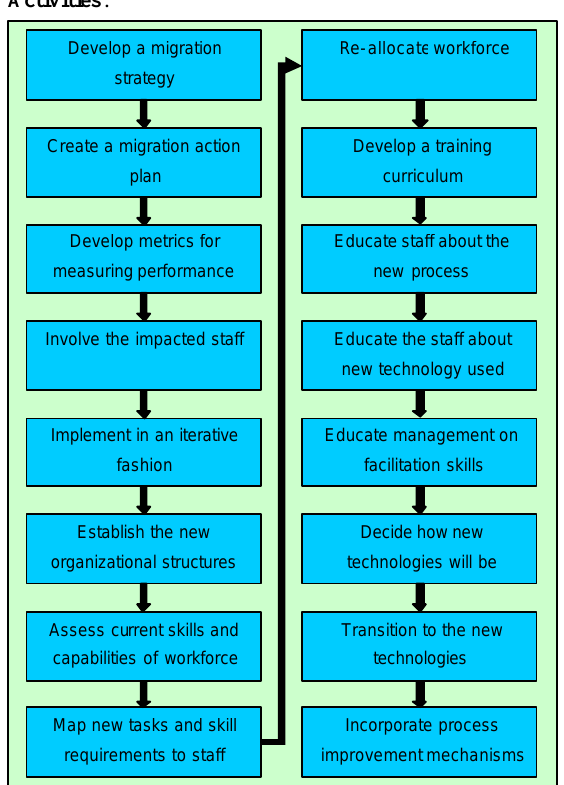
Figure 7: Activities Performed in Phase